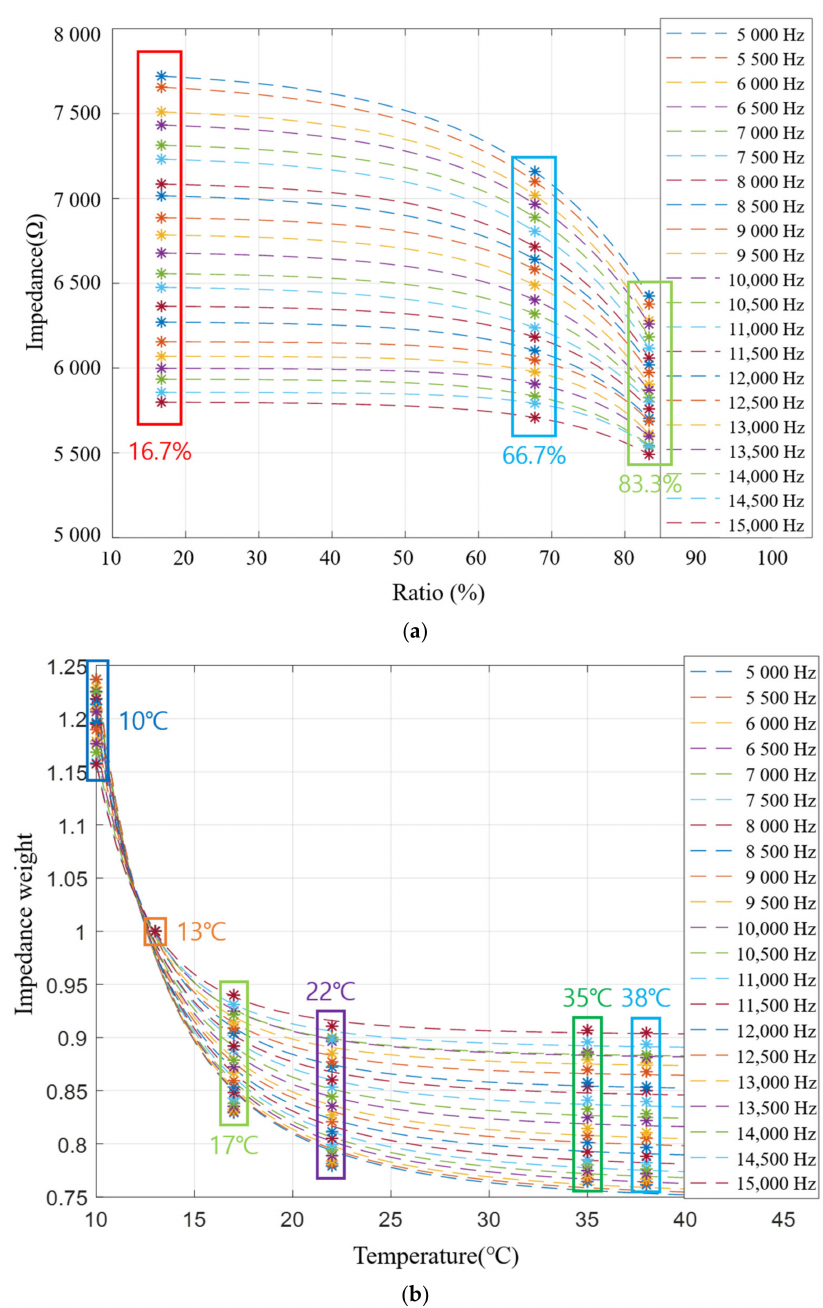
Figure 16. Modified impedance graph and impedance weight graph: ( a ) Estimated impedance by each frequency; ( b ) Impedance weight by each